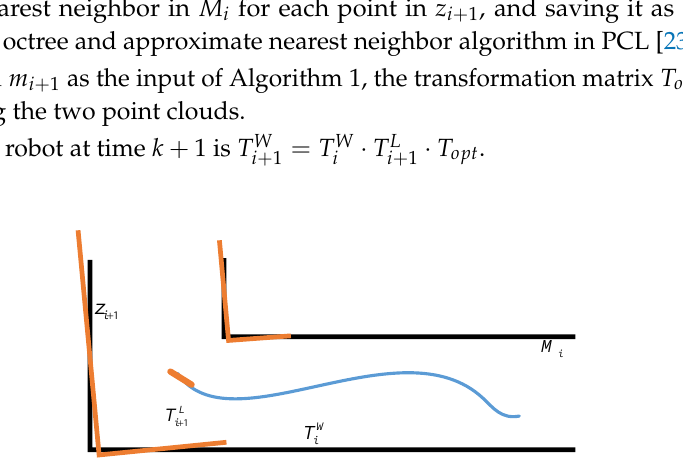
Figure 2. The matching process of the current frame and map.